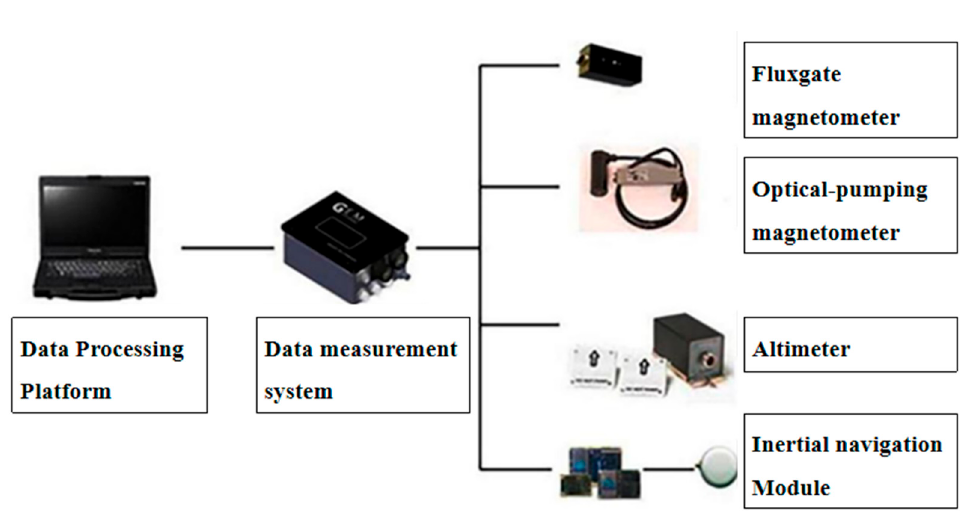
Figure 9. Aeromagnetic measurement equipment.